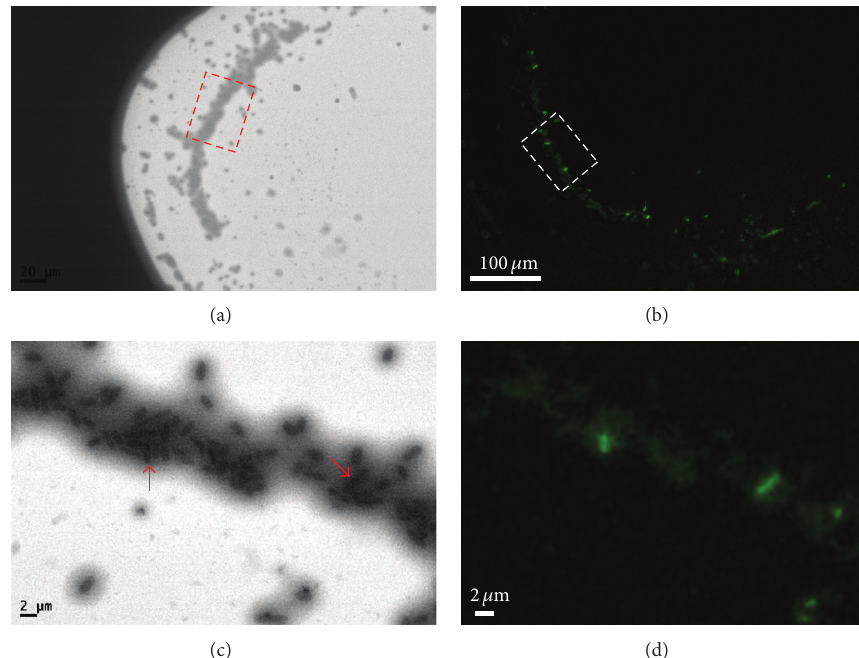
Figure 2: In situ TEM images (a, c) and corresponding fluorescence microscopy images (b, d) of E. coli cells in the liquid chamber after high energy beaming. The fluorescence images were obtained after TEM exposing. (c) and (d) are magnifications from squares in (a) and (b). The red arrows in (c) pointed to two cells which emitted obvious green fluorescence in